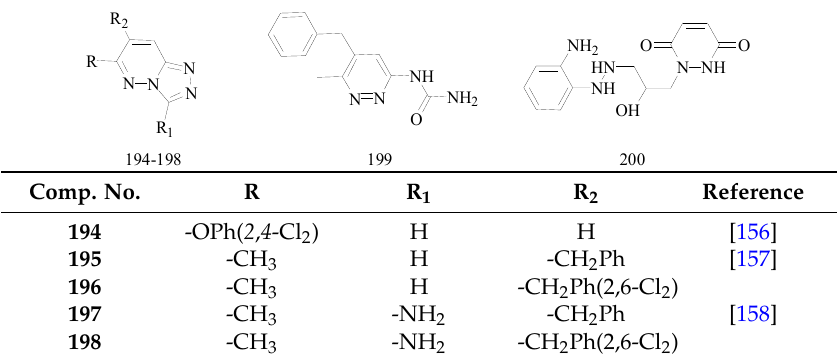
Table 10. Structures of compounds 194 – 200